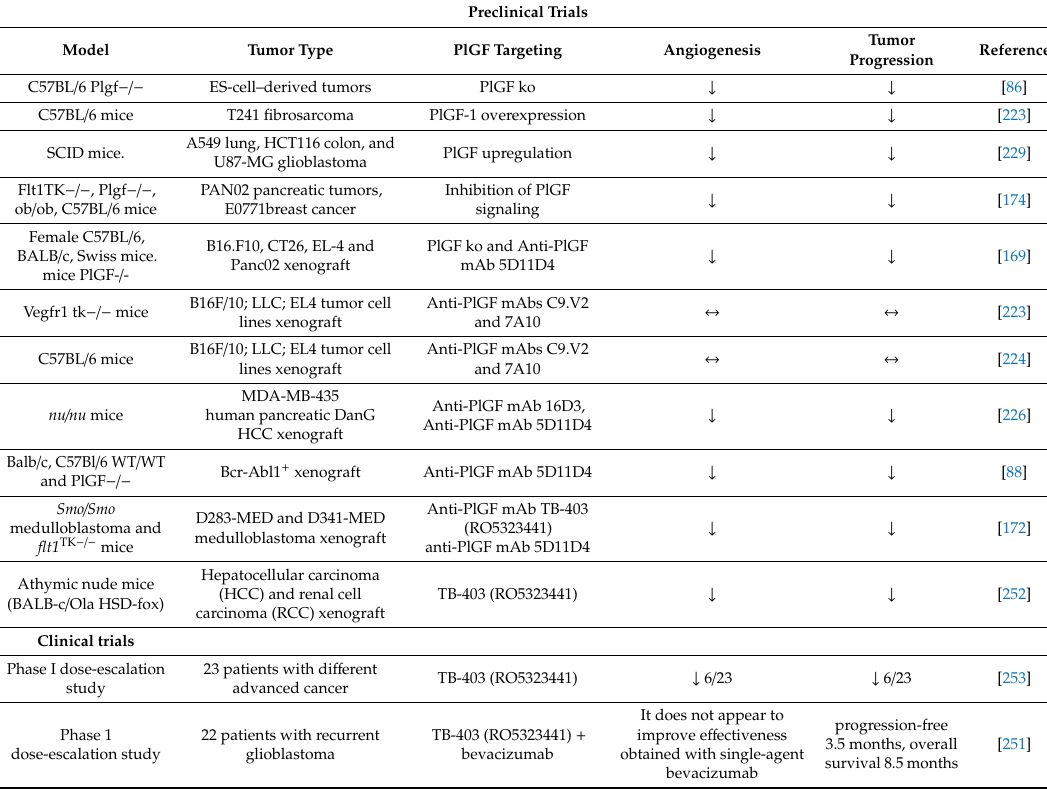
Table 1. Preclinical and clinical studies resulting in PlGF downregulation or